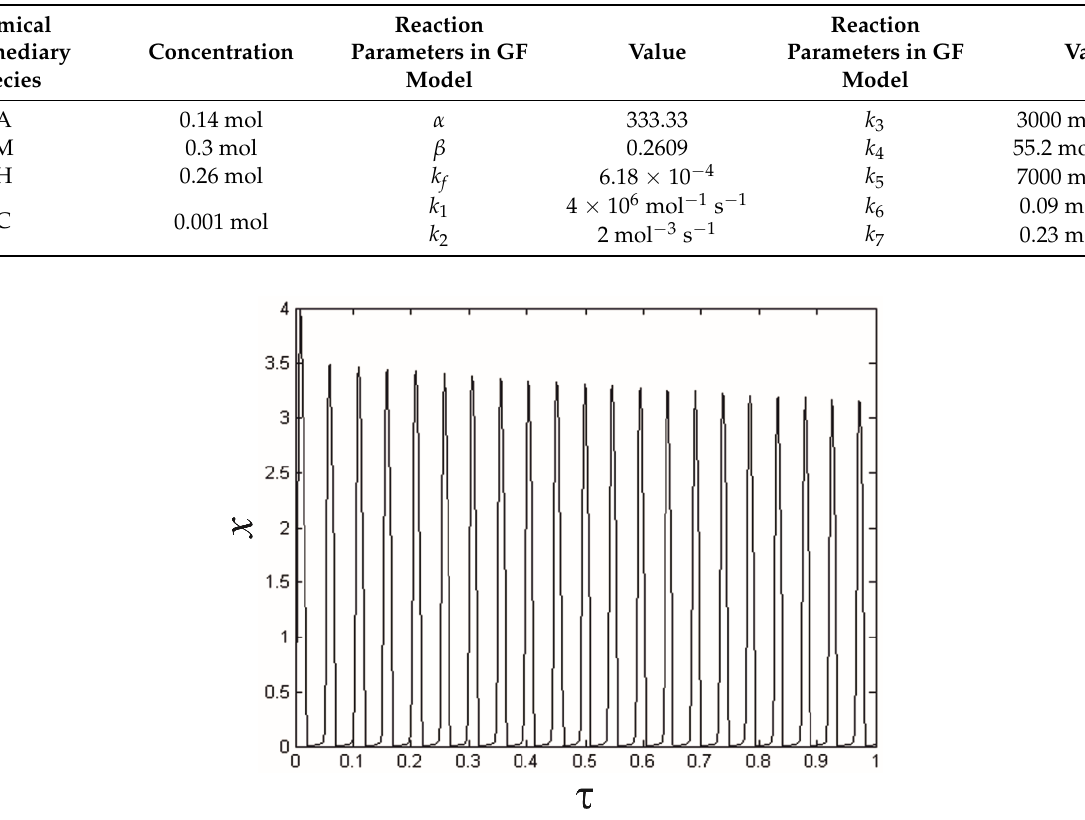
Figure 7. The evolution of the x ( τ ) concentration at high flux (α = 3000/9; β = 6/23; C = 0.001; A = 0.14 mol; M = 0.3 mol; H = 0.26 mol and k f = 6.18 × 10 −4 ) and initial values: x (0) = 0.045; z (0) = 0.9; v (0) = 0.85.